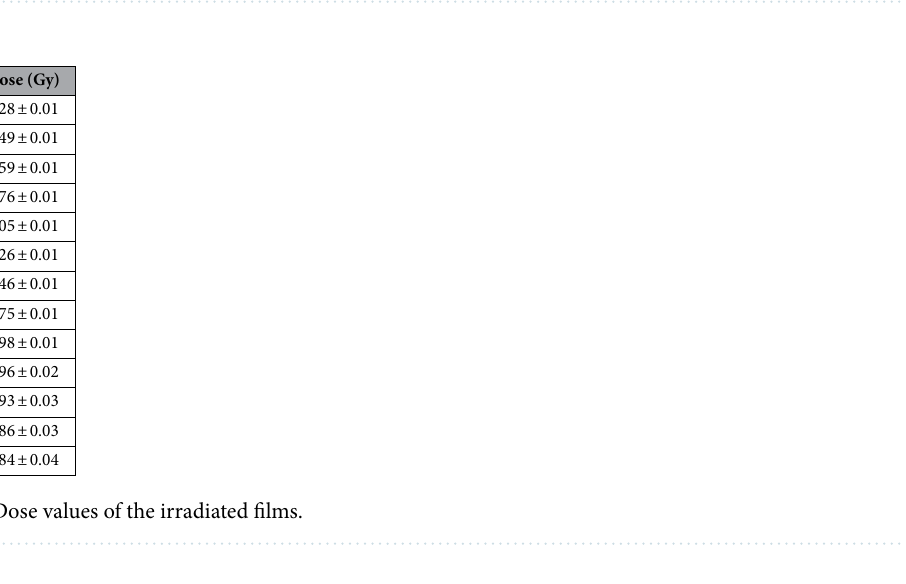
Figure 4. EBT3 calibration curves for one incident proton energy (12.8 MeV) for both red and green channels as films are scanned 48 h after irradiation.